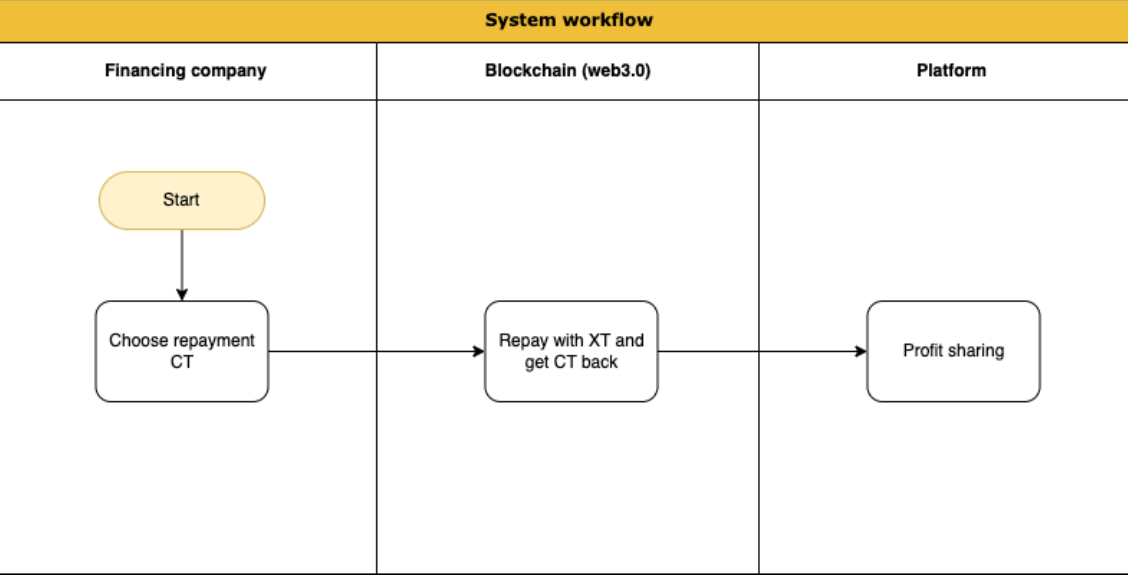
Figure 13. The workflow of repayment in finance management.